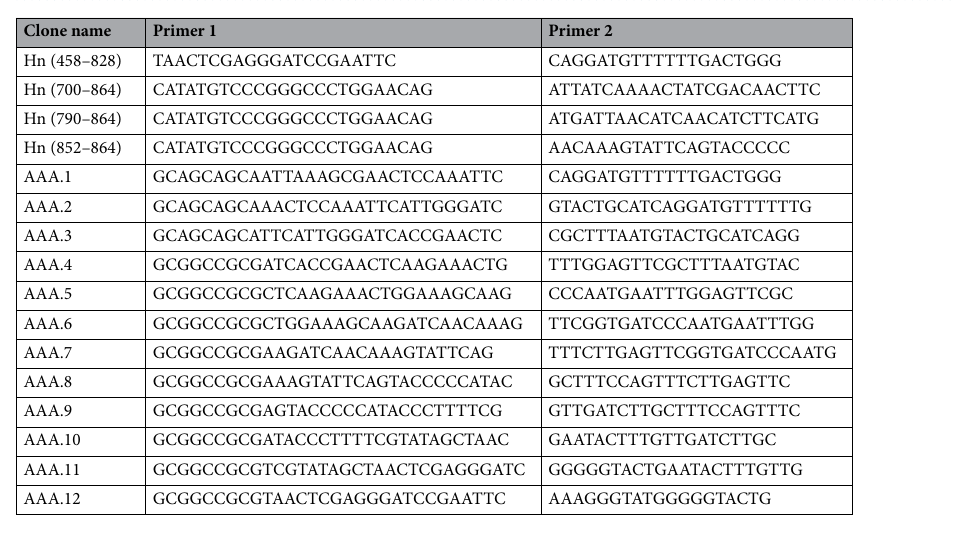
Table 3. Primers used to construct Hn mutant expression